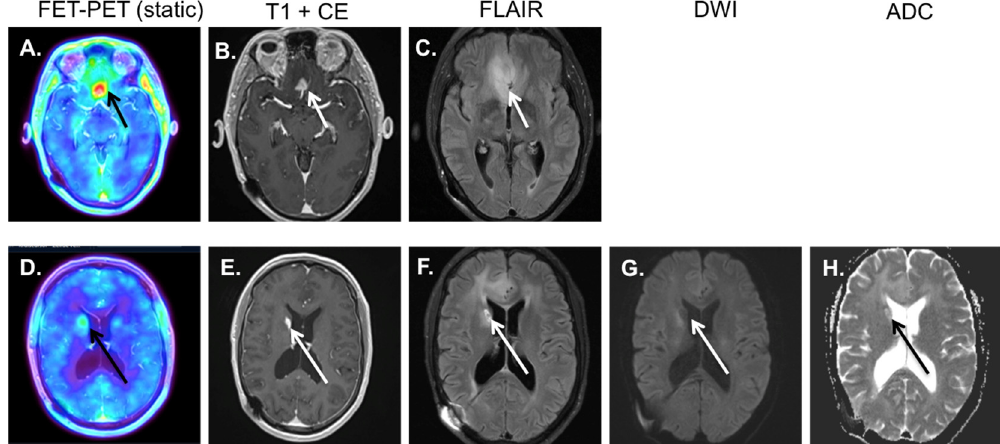
Figure 3. Patient with an anaplastic astrocytoma, 3 months after radiotherapy and temozolomide treatment. On the MRI, a persistent contrast enhancement is visible in the lesion (frontal lesion marked with white arrow ( B )), with increased signal intensity on the FLAIR (see white arrow ( C )). Based on MRI alone, pseudo ‐ progression cannot be distinguished from real progression. The 18 F ‐ FET ‐ PET shows a strongly increased accumulation of the tracer, typical for viable tumor tissue (black arrow 18 F ‐ FET ‐ PET image ( A )). This is confirmed by biopsy. Furthermore, the 18 F ‐ FET ‐ PET shows a second area with increased tracer accumulation at the caput caudate nucleus on the right side (black arrow 18 F ‐ FET ‐ PET image ( D )). However, this was a false positive, as the MRI (white arrows ( E , F )) and DWI/ADC (white and black arrow on ( G , H )) show clear signs of ischemia, possibly secondary to radiotherapy. This example shows how these modalities can be complementary to each other.